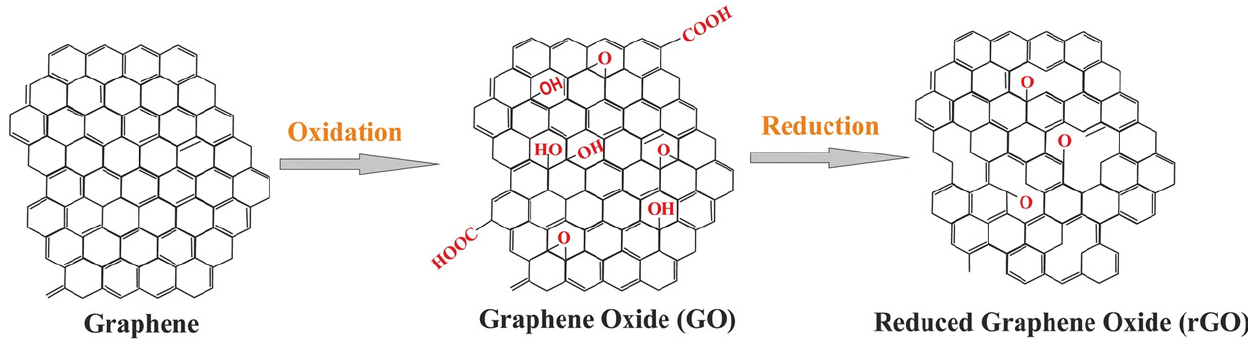
Figure 1. Conversion of graphene into GO and rGO. Reprinted from Ref. [34].